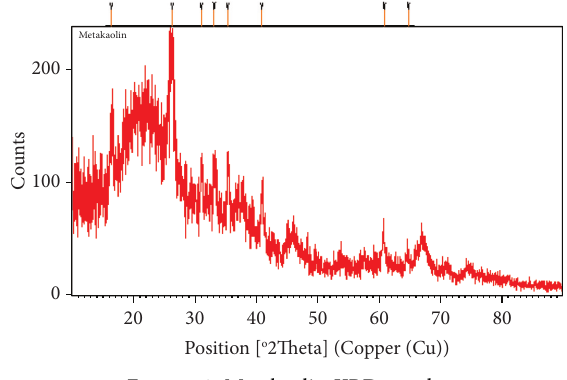
Figure 4: Metakaolin XRD graph.